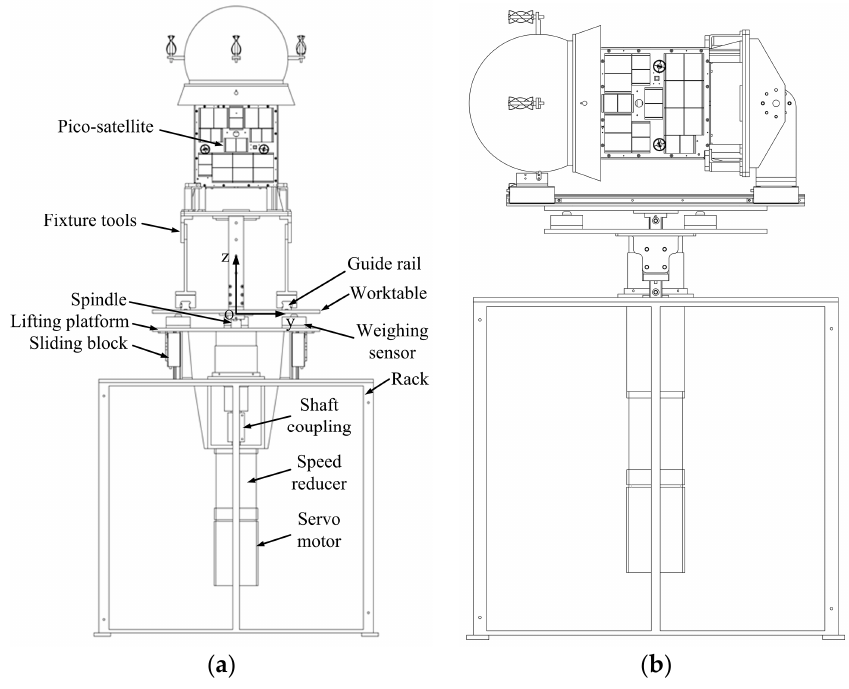
Figure 3. Pico-satellite schematic diagram ( a ) vertical position; ( b ) horizontal position. Table 1. The main parameters of the servo motor.